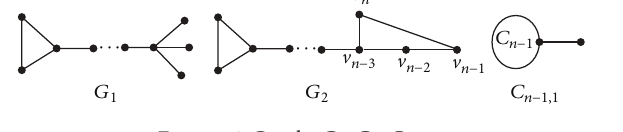
Figure 6: Graphs 𝐺 1 , 𝐺 2 , 𝐶 𝑛−1,1 .